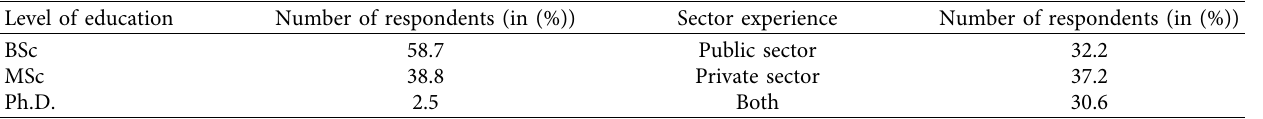
Table 3: Questionnaire respondents’ level of education and sector